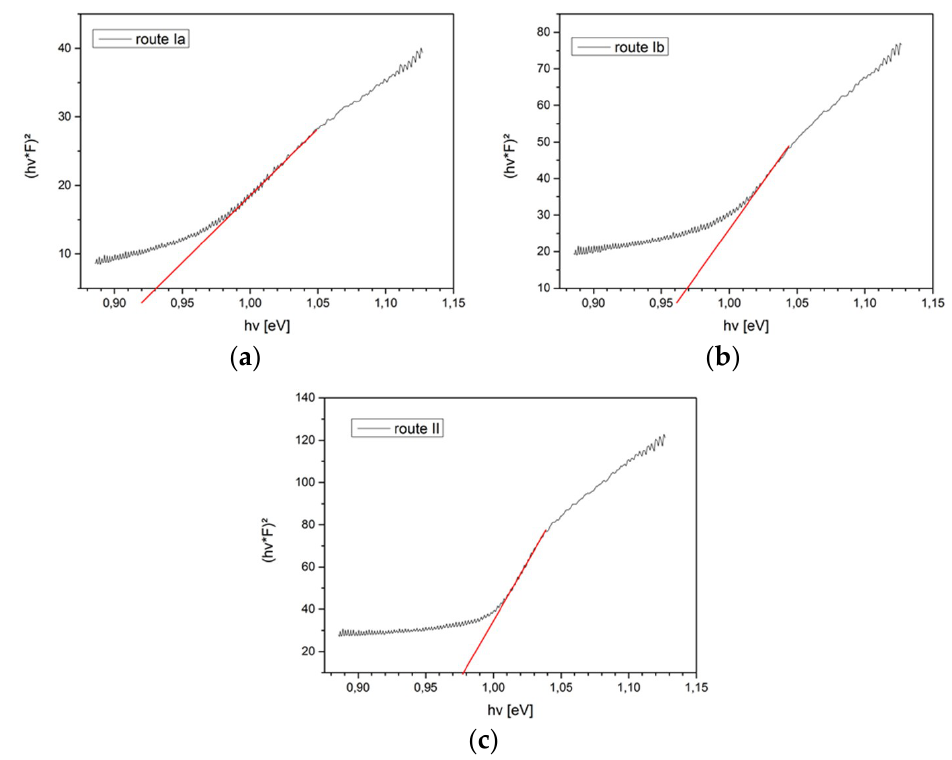
Figure A2. Tauc plots of different CISe‐film samples derived form reflectivity measurements. ( a ) From Cu‐In + Se precursor after face‐to‐face annealing at 550 °C for 5 min with 46.1 kN/m² pressure. ( b ) From Cu‐In + Se precursor with seeding layer after face‐to‐face annealing at 550 °C for 5 min with 46.1 kN/m² pressure. ( c ) From Cu 2− x Se + In 2 Se 3 precursor after face‐to‐face annealing at 550 °C for 5 min with 46.1 kN/m² pressure.